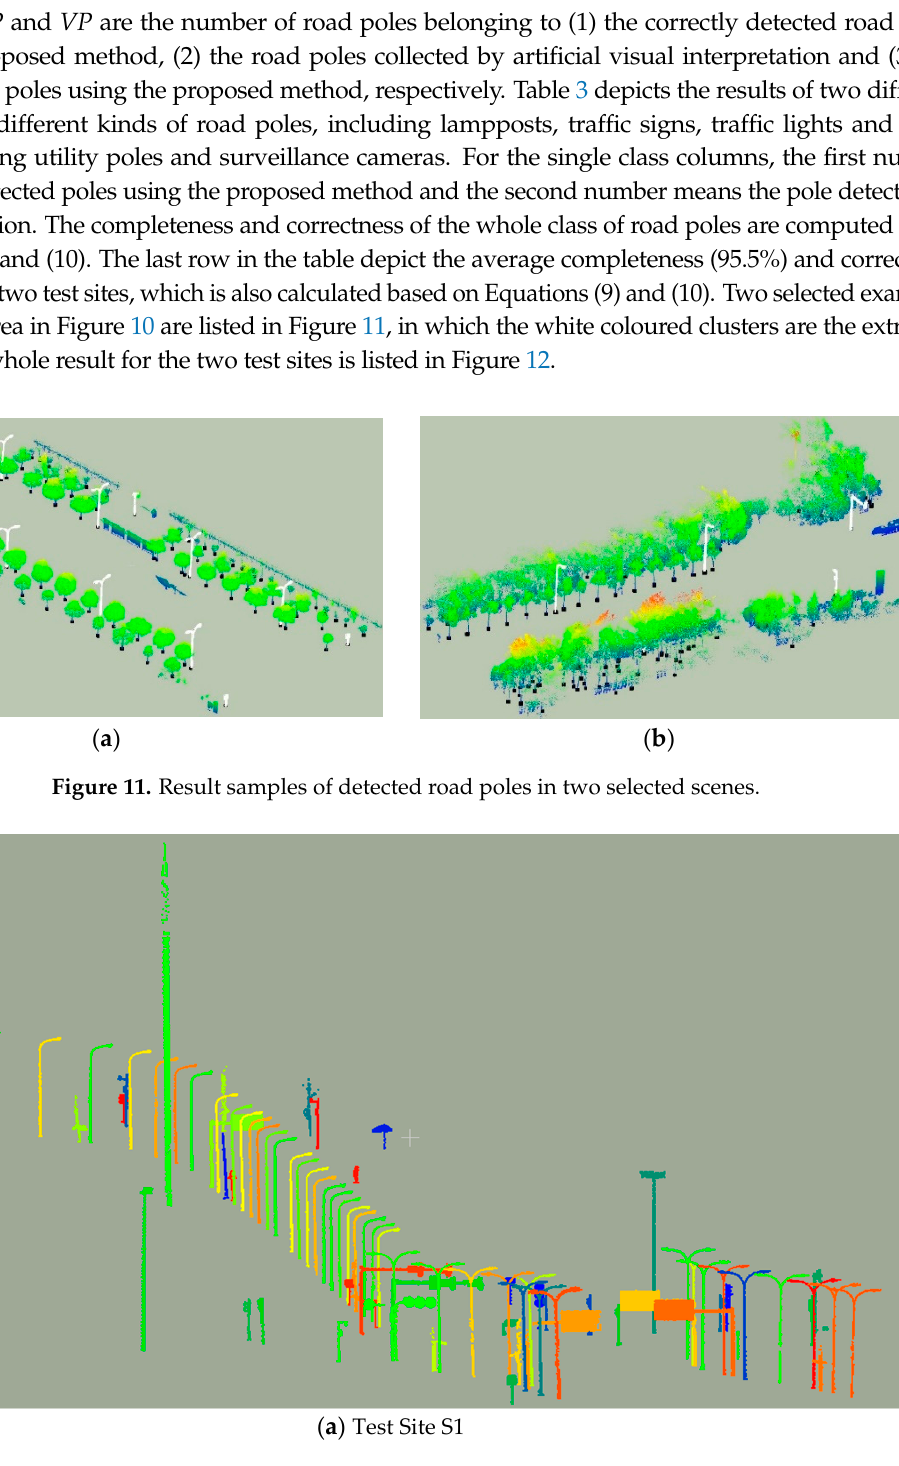
Table 3. Detection results in the test sites.